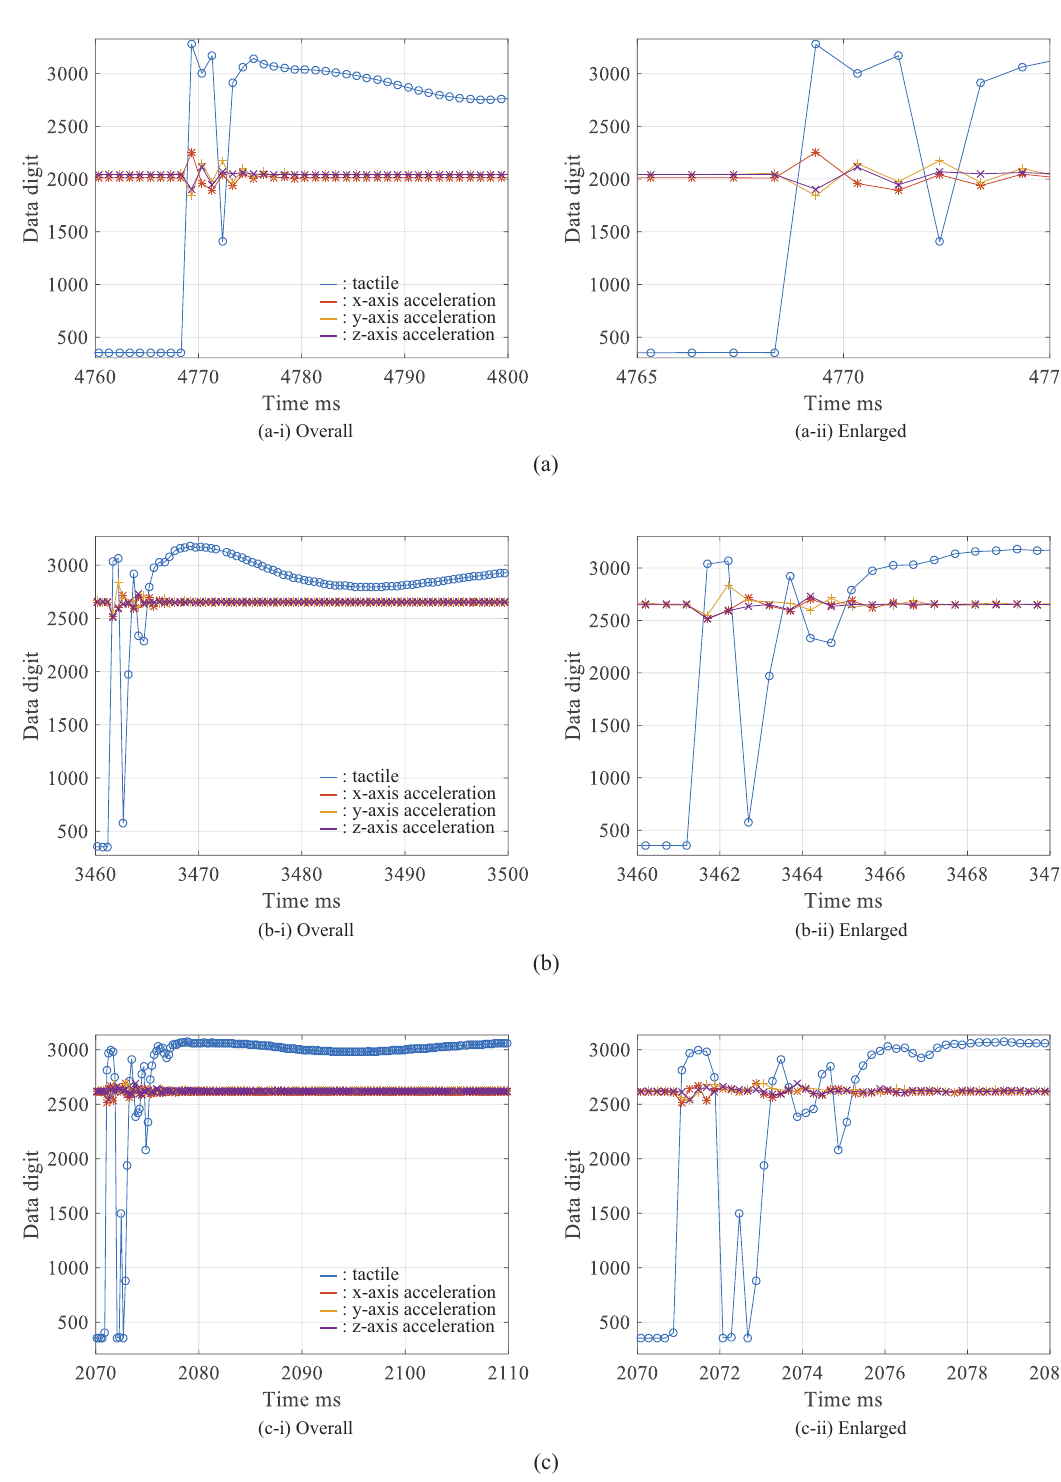
Figure 8. Experimental results with various sampling rates: ( a ) sampling time is 1 ms, ( b ) sampling time is 0.5 ms, and ( c ) sampling time is 0.2